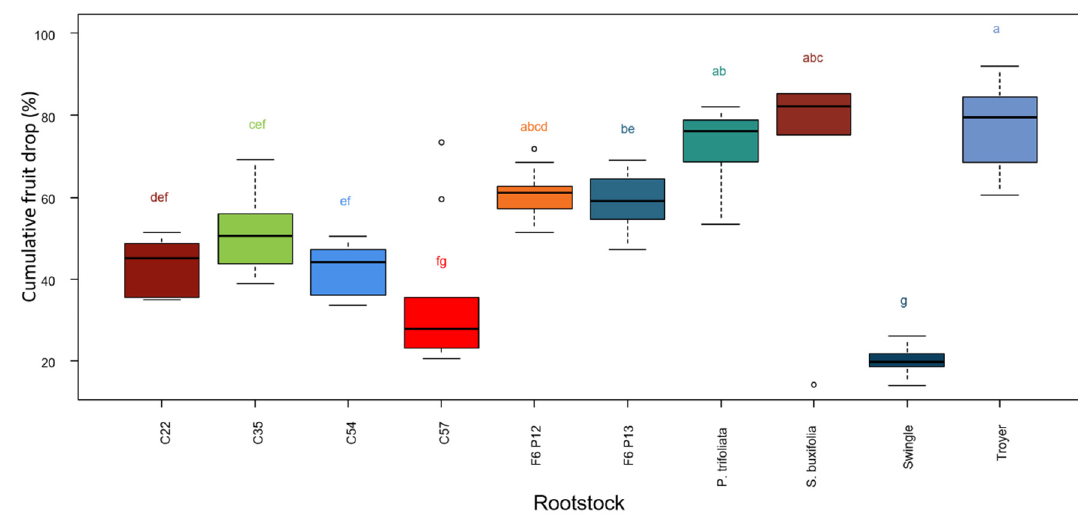
Figure 7. Percentage of fruit drop in Mandared grafted onto 10 rootstocks, recorded between 2016 and 2019. Different letters indicate significantly different means according to Tukey’s test at p < 0.05. Different colors of the boxes indicate different significance groups.